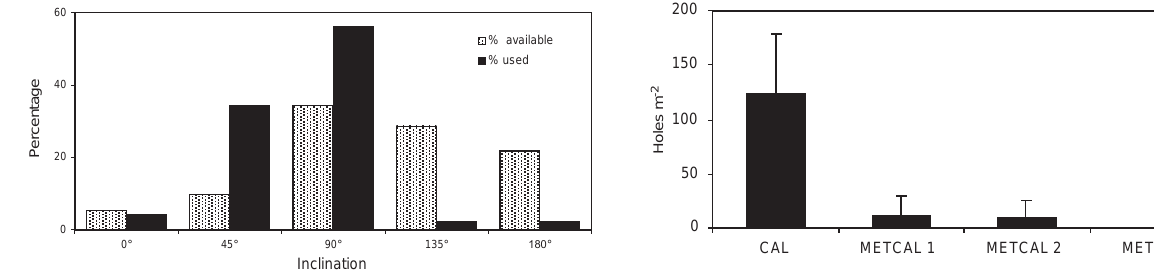
F IG . 4. – Proportion of available substrate by inclination range (total surface: 347 m 2 ) and proportion of recently settled individuals found in the different inclination ranges (n =